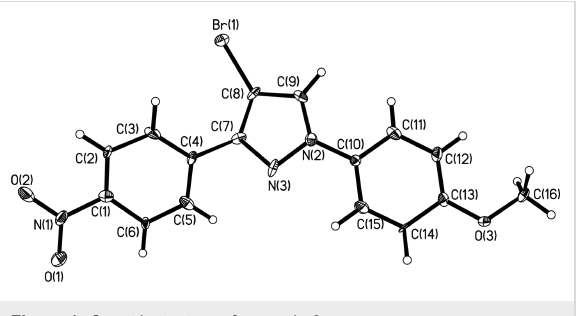
Figure 1: Crystal structure of pyrazole 3g .